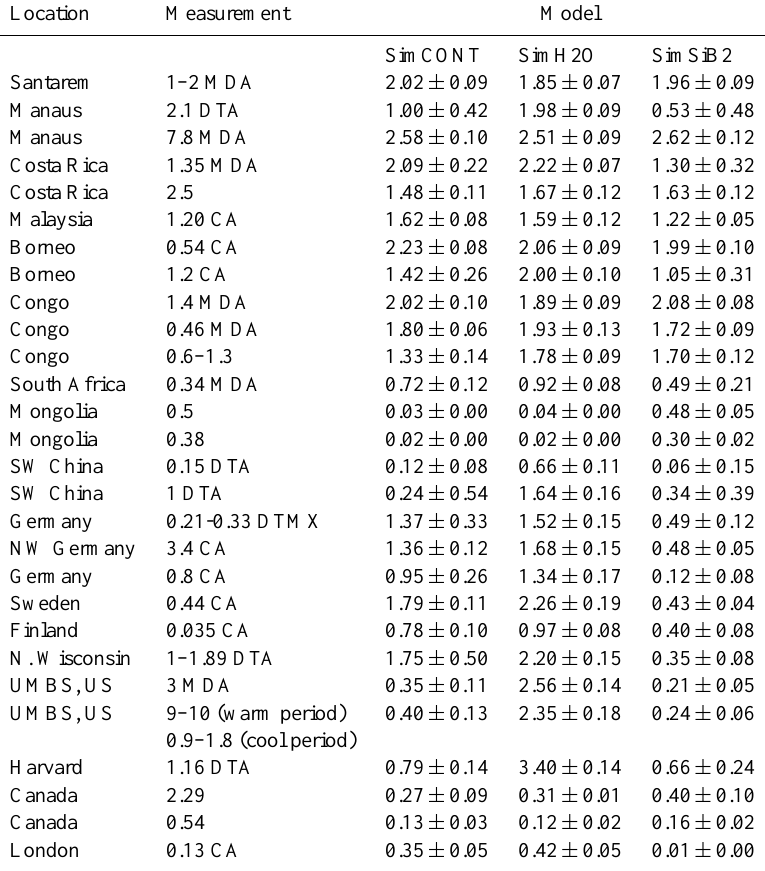
Table 5. Comparison of the global database and simulated isoprene emission. Units aremgCm − 2 h − 1 . The model values are either monthly or seasonal means to be consistent with the observation time period. The averaging period for the observations is indicated where the information is available. [MDA=mid-day average; DTA=daytime average; CA=campaign average; DTMX=daytime